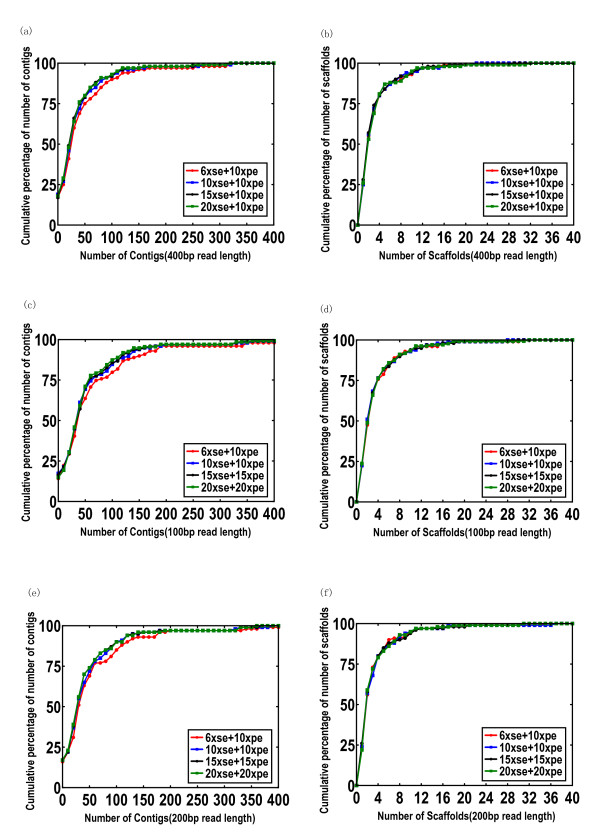
Number of contigs/scaffolds from assembly results of 100 randomly selected prokaryotic genomes by different sequencing strategies. (a) Cumulative percentage distribution of number of contigs from 100 genomes by different sequencing strategies. (b) Cumulative percentage distribution of number of scaffolds from 100 genomes by different sequencing strategies.